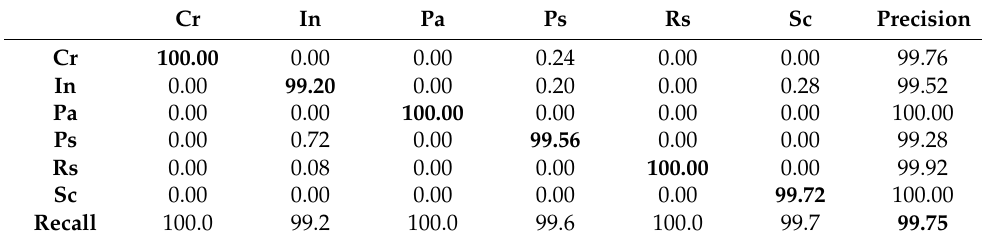
Table 3. The confusion matrix of MRFFN + IA based on the NEU dataset